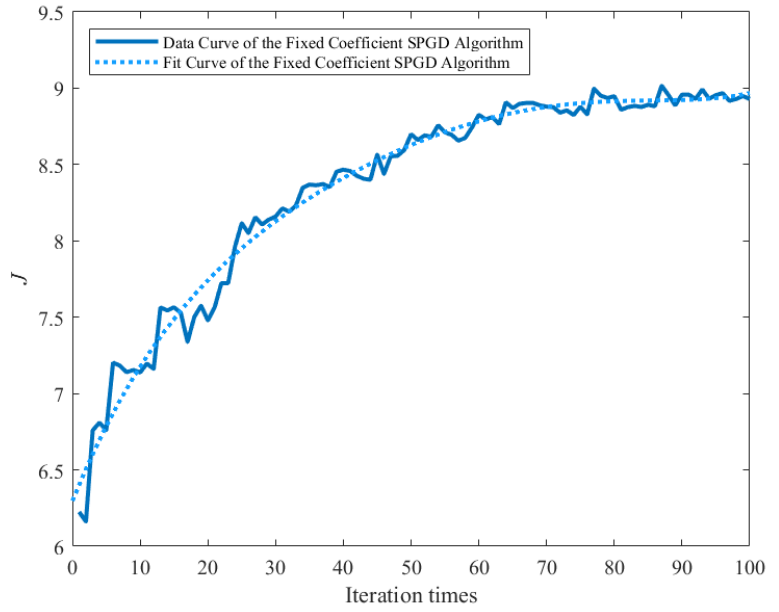
Figure 7. Metric convergence curve of the fixed coefficient SPGD algorithm.